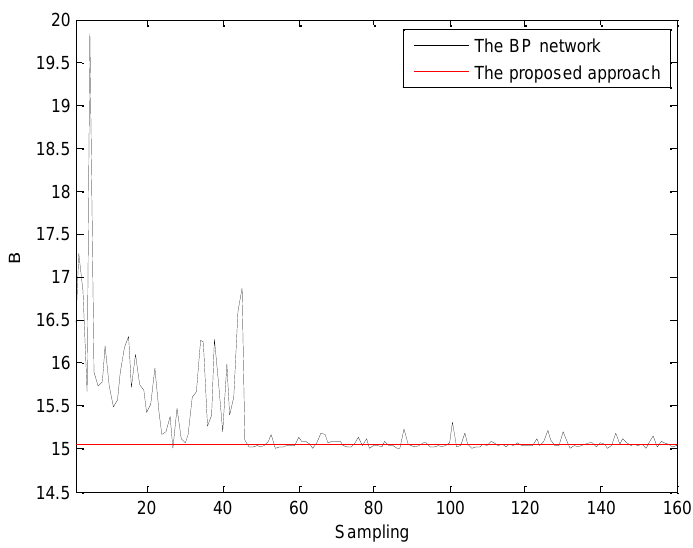
Figure 15. The comparison between BP network and the proposed approach.